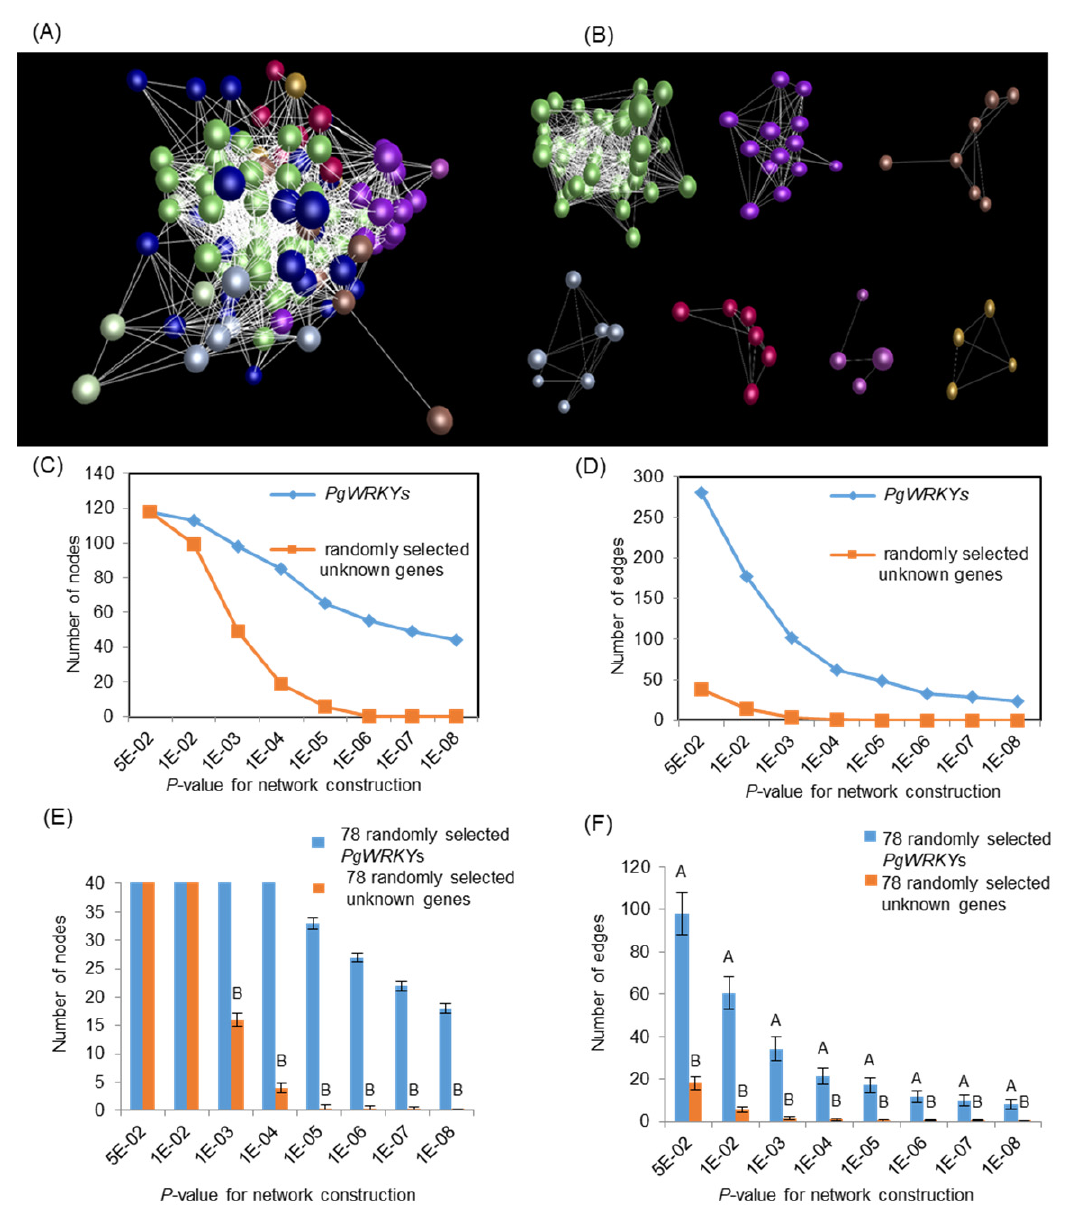
Figure 8. Network analysis of the PgWRKY genes expressed in the 4-year-old roots of 42 farmers’ cultivars. ( A ) The co-expression network constructed from the 118 PgWRKYs . The network was constructed at p ≤ 0.05. ( B ) The three clusters constituting the network. Different clusters are indicated by different colors. ( C ) Tendency that these PgWRKYs form a network, with the randomly-selected ginseng unknown genes as controls: variation in number of nodes. ( D ) Tendency that these PgWRKYs form a network, with the randomly-selected ginseng unknown genes as controls: variation in number of edges. ( E ) Statistical analysis of variation in number of nodes in the network. ( F ) Statistical analysis of variation in number of edges in the network. Different capital letters, significant at p ≤ 0.01. Error bar, standard deviation for 20